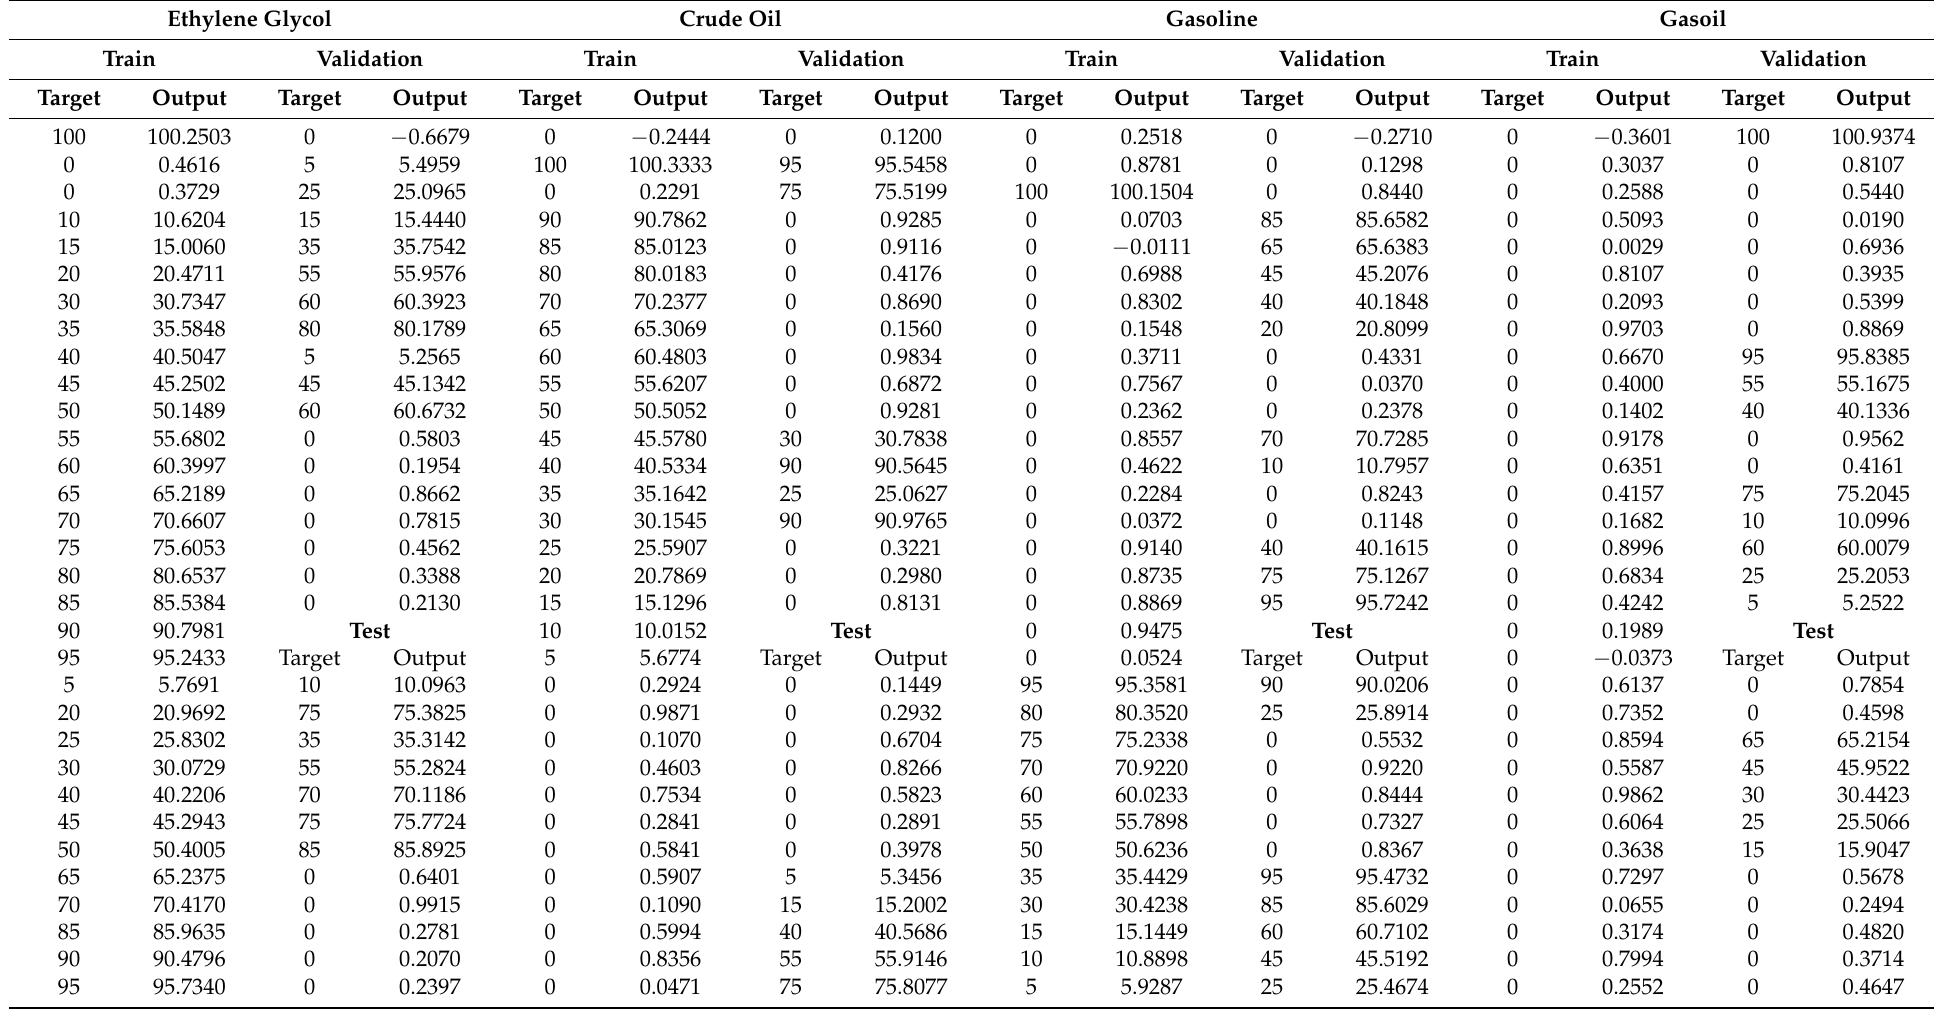
Table 2. Comparison of target values with neural network